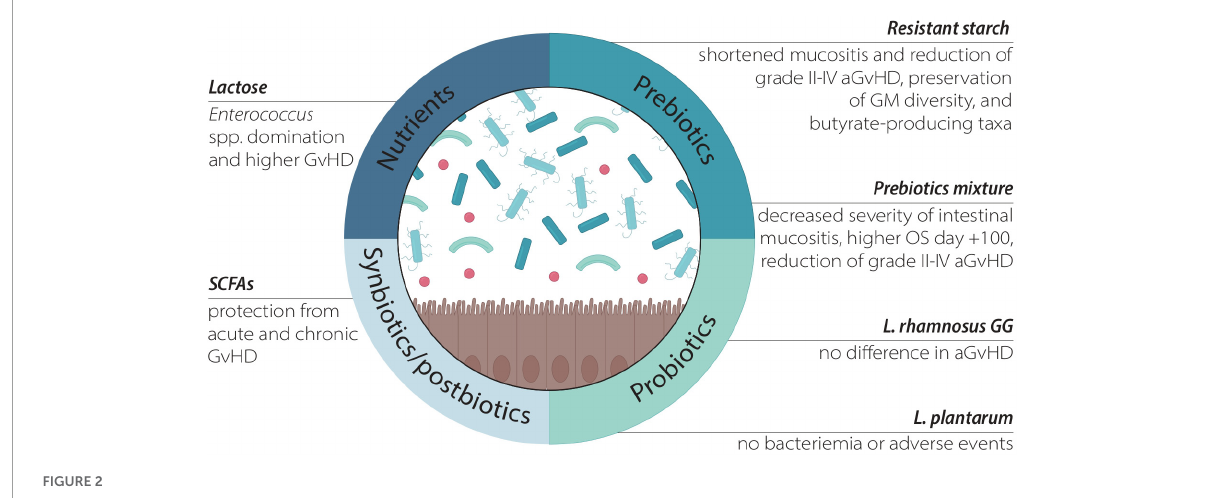
FIGURE2 The effect of different nutritional compounds targeting the GM.